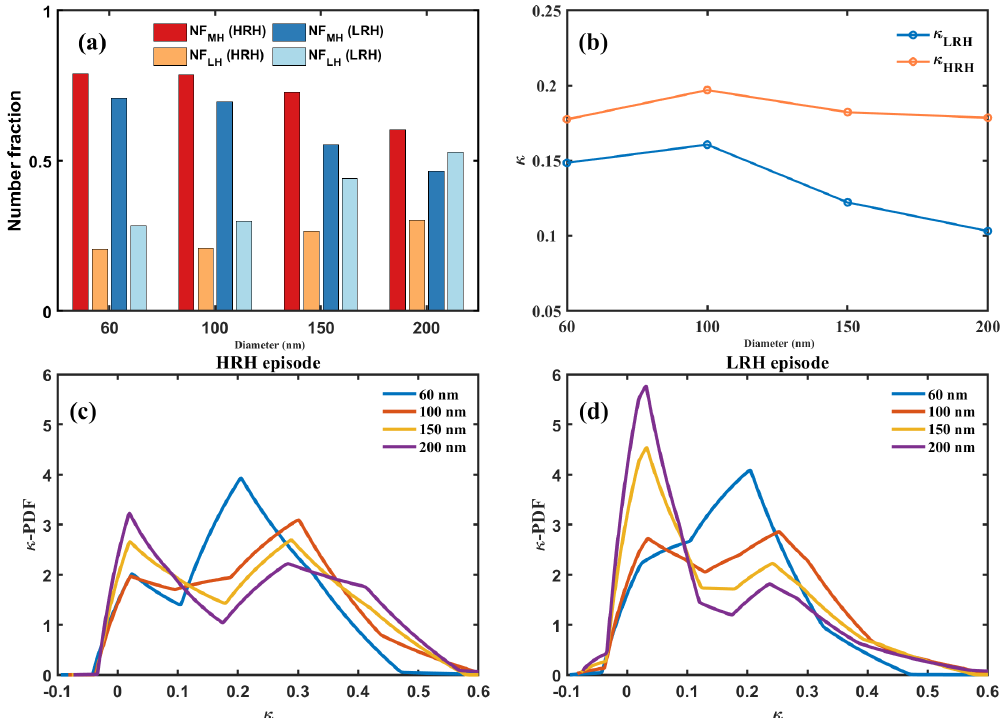
Figure 4. Number fractions of the MH mode and LH mode in particles at 60, 100, 150, and 200nm and the average κ value of particles at each size under the HRH and LRH